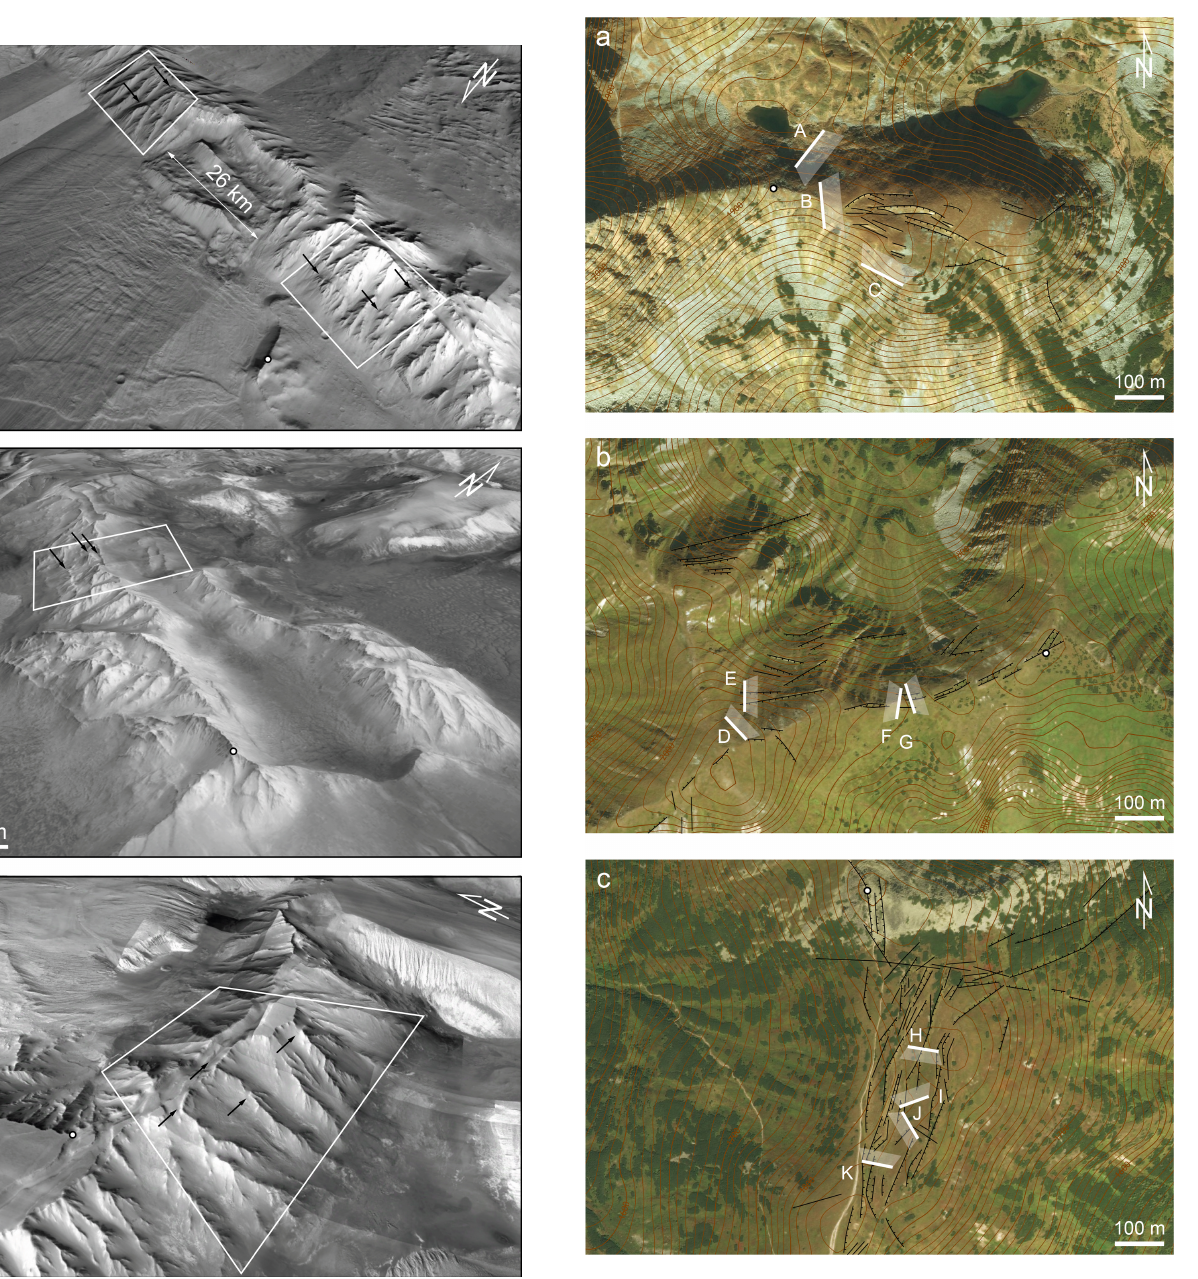
Figure 4. Tatra study sites and location of field photographs (Fig. 5). Lines are fault scarps, dashes indicate the downthrown block. For better readability, or where the scarp orientation is not well defined, they are not always drawn. White dot indicates land- mark for easier site localisation, with coordinates using the WGS84 datum. (a) Site T1, east from Jamnícke Sedlo. Landmark is at 49 ◦ 12 (cid:48) 04 . 5 (cid:48)(cid:48) N, 19 ◦ 45 (cid:48) 48 . 0 (cid:48)(cid:48) E. (b) Site T2: a ridge west of Vel’ká Garajova Kopa. Landmark is at 49 ◦ 12 (cid:48) 09 . 0 (cid:48)(cid:48) N, 19 ◦ 58 (cid:48) 59 . 0 (cid:48)(cid:48) E. (c) Site T3: ridge south from Ornak. Landmark is at 49 ◦ 12 (cid:48) 46 . 5 (cid:48)(cid:48) N, 19 ◦ 50 (cid:48) 08 . 5 (cid:48)(cid:48) E. Imagery is from ESRI World Imagery; contours are extracted from ASTER GDEM. ASTER GDEM is a product of METI and